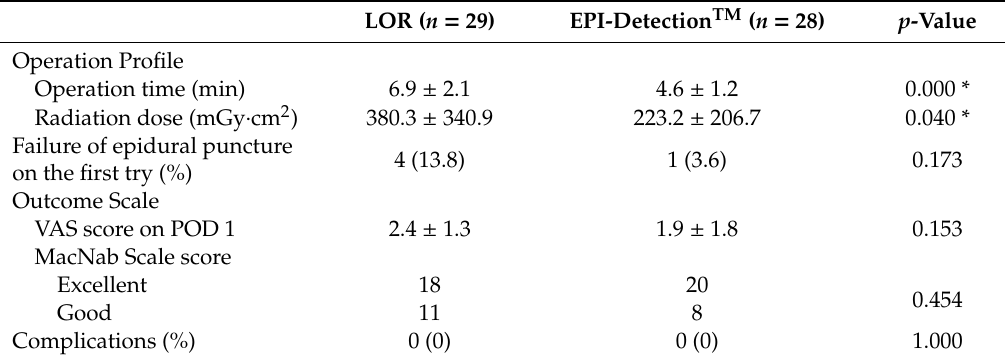
Table 2. Comparison of the operation time and radiation dose.